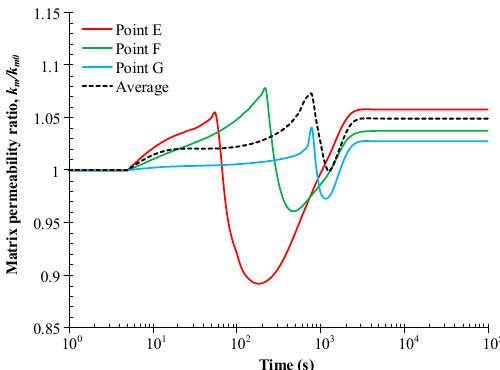
Figure 10. Temporal evolution of matrix permeability ratio.